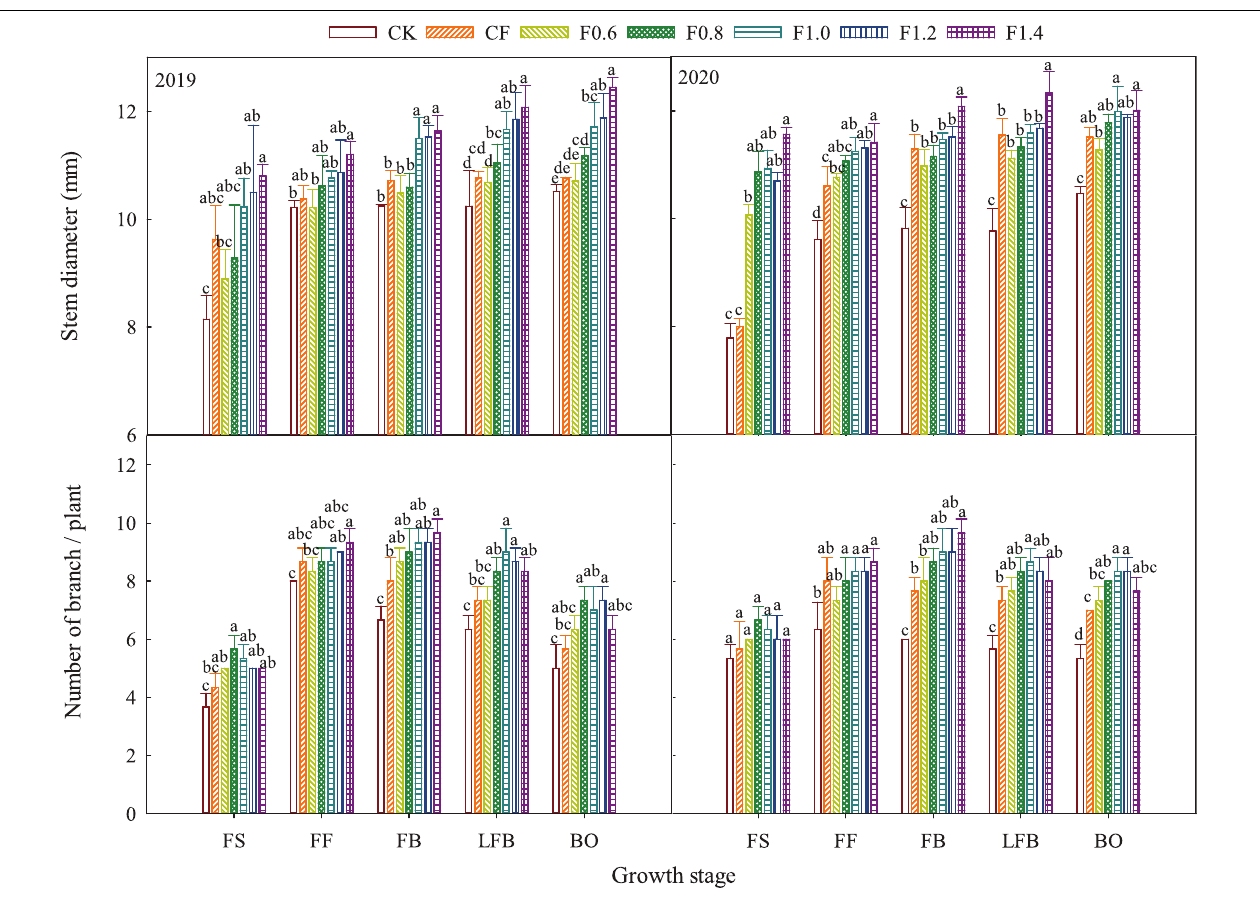
FIGURE 4 | The changes of cotton stem diameter and cotton branches in different fertilization treatments. FS, full squaring stage; FF, full flowering stage; FB, full boll stage; LFB, later full boll stage; BO, boll opening stage. Different letters above the adjacent seven columns indicate statistical significance at the P = 0.05 level.